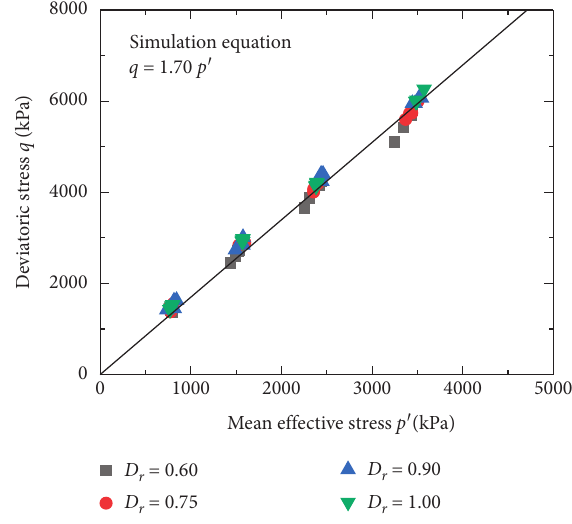
Figure 3: Critical state point and trend line in p ′ ∼ q